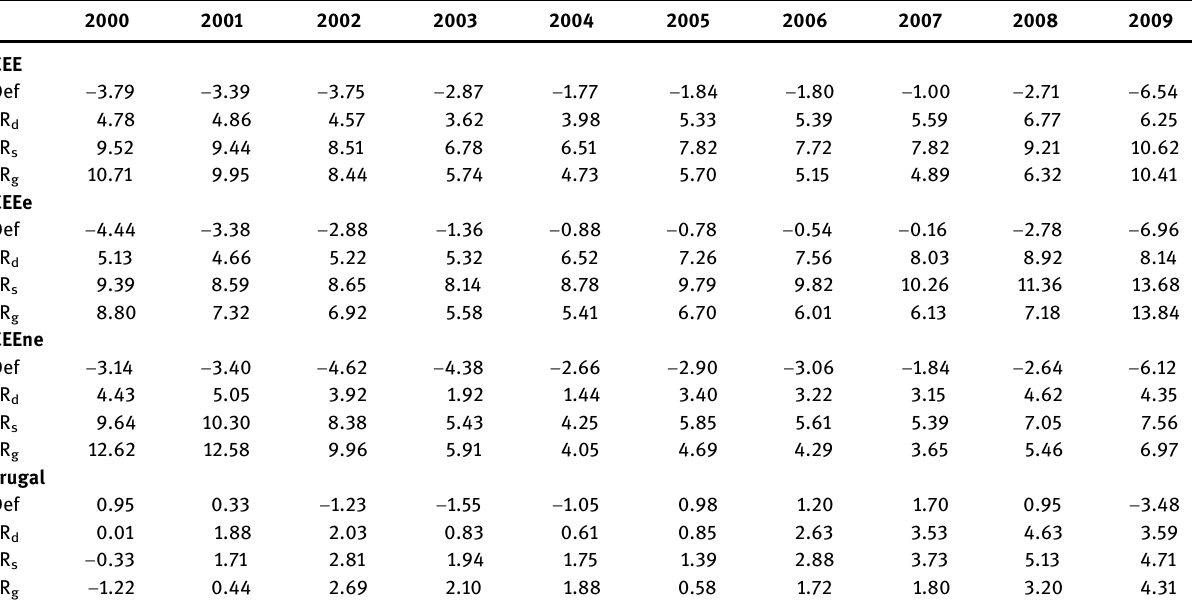
Table 1C: Government de fi cit ( − ) /surplus (+) , 2000 – 2009, ψ =